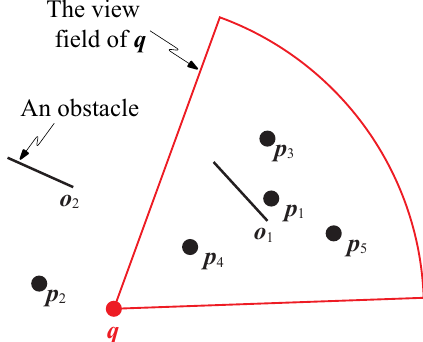
Figure 1. Example of finding k visible nearest data objects in the view field of q ( k = 2 )